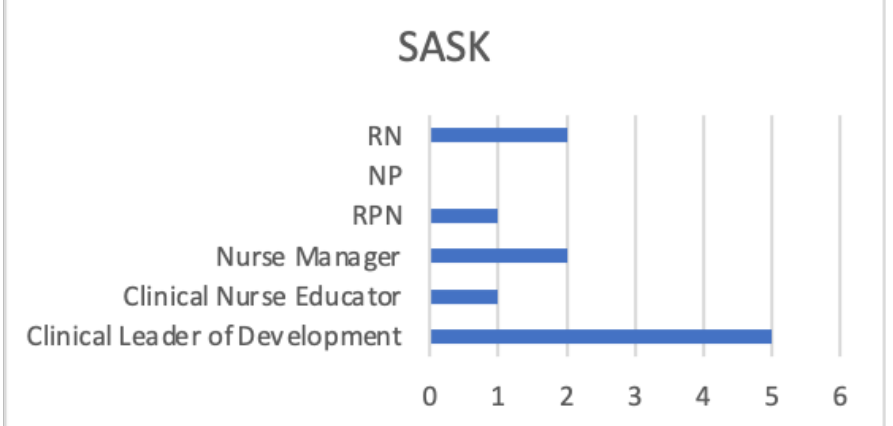
Figure 4: Nursing Profile of Saskatchewan Participants